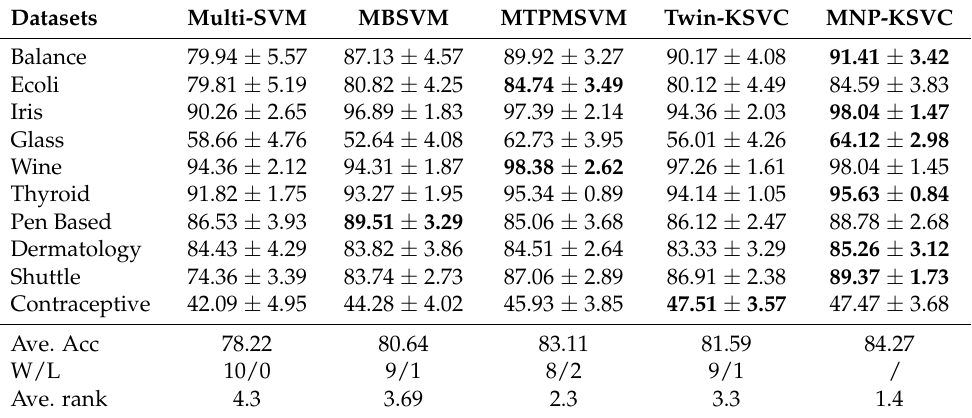
Table 3. Performance comparison on benchmark datasets for nonlinear classifiers, in terms of the mean ± std of the testing multiclass accuracy (%). The Win/Loss (W/L) denotes the number of datasets for which MNP-KSVC is superior/inferior to the compared classifiers. Ave. Acc and rank denote each classifier’s average accuracy and rank over all datasets.